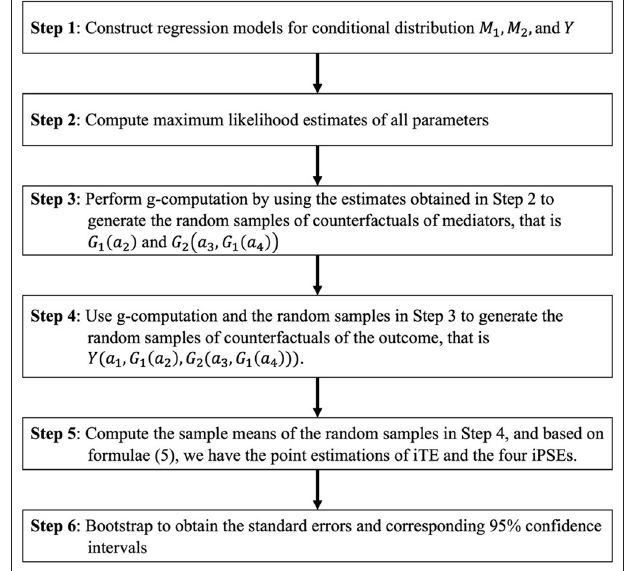
FIGURE 5 | Flow chart for the proposed simulation-based approach. M 1 , M 2 , and Y represent the first mediator, second mediator, and outcome,